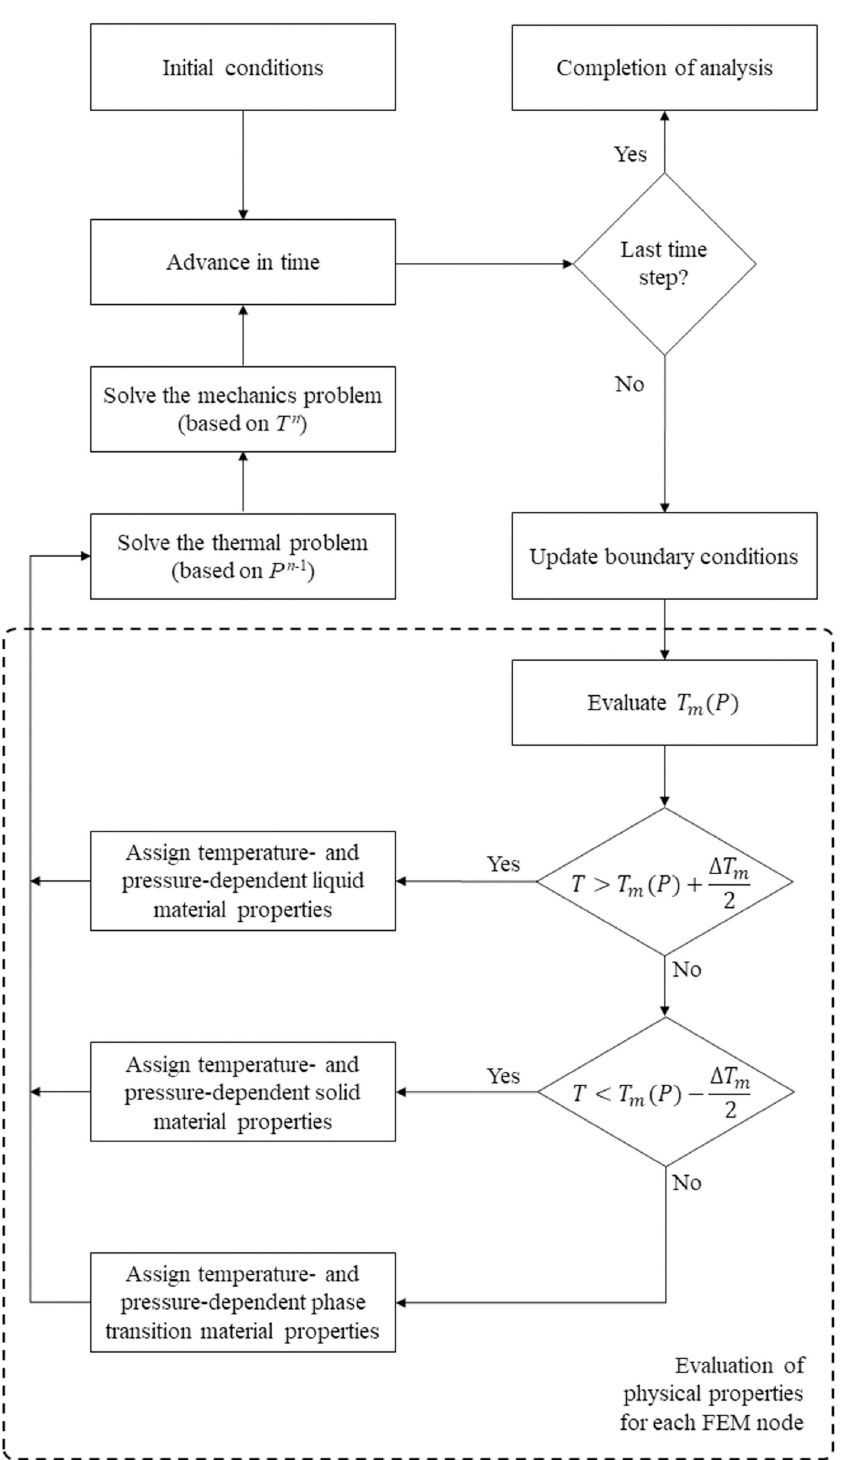
Fig 3. Flow diagram for computation using the proposed model. The symbol n is a time index.